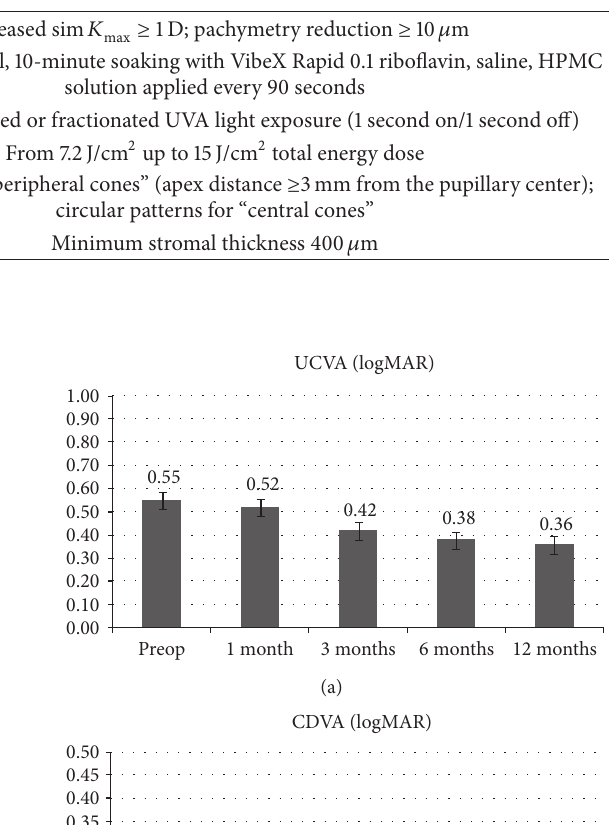
demarcation line, measured from epithelial surface, was 150 ± 18 𝜇 m SD in the flatter corneal area and 300 ± 37 𝜇 m